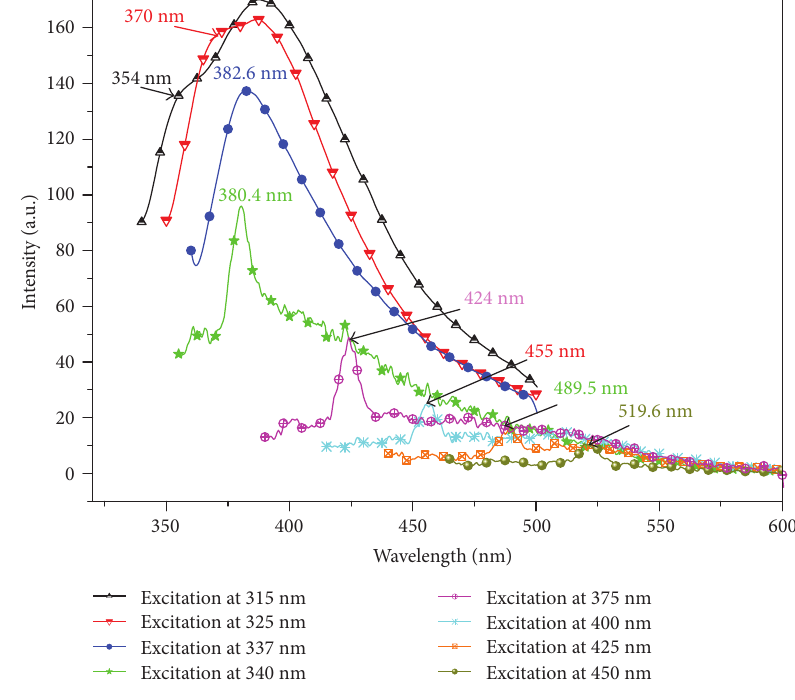
Figure 5: Resonance Raman spectra for acetone. Table 1: Resonance Raman spectra of